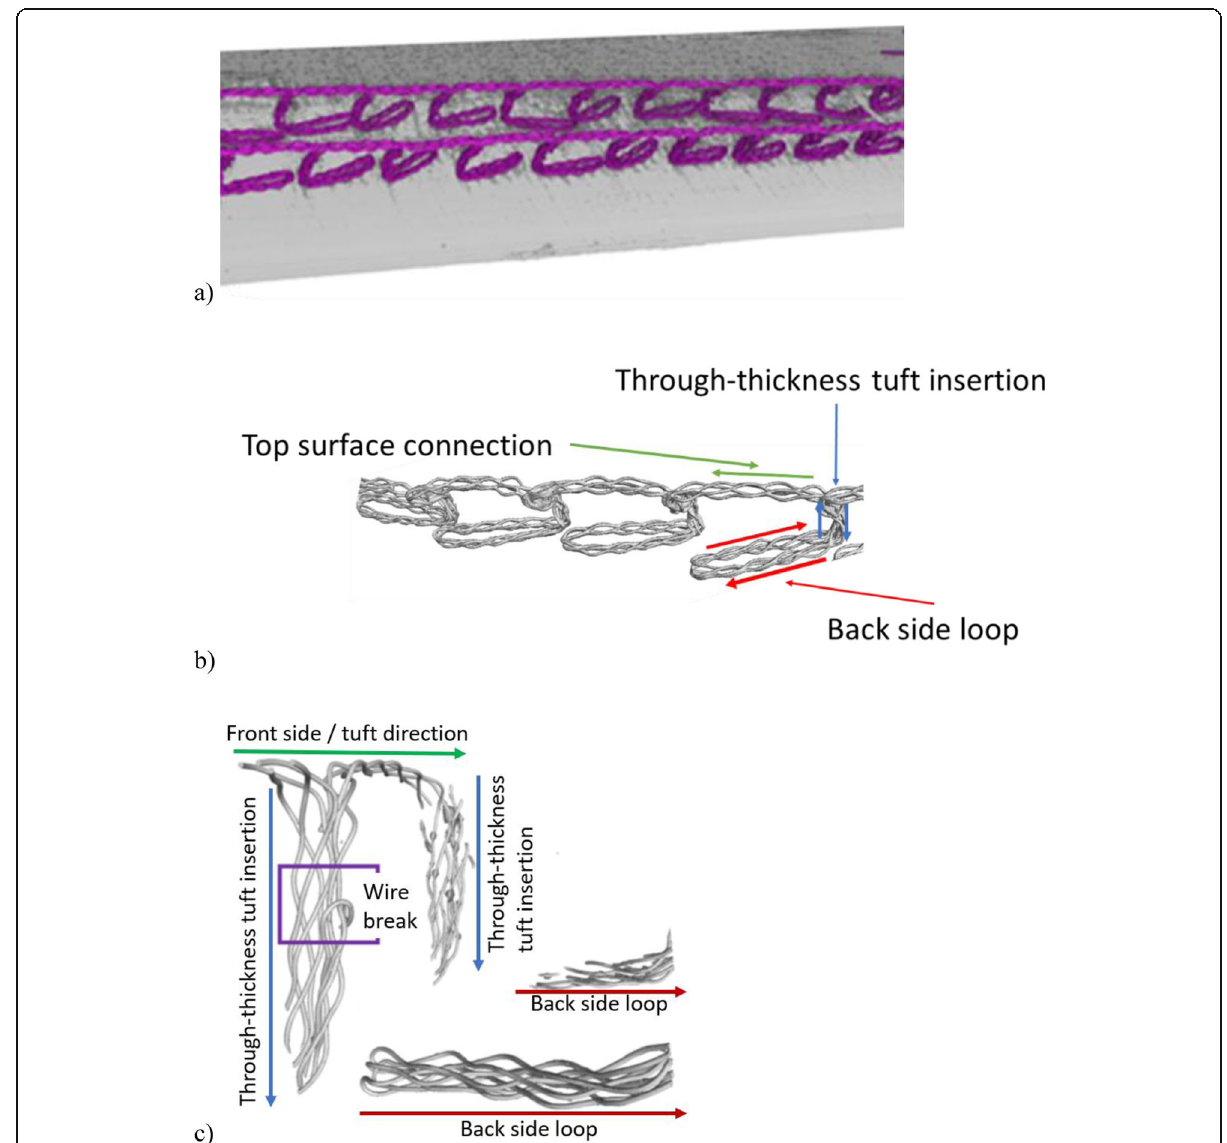
Fig. 5 CT scan highlighting path of metal wire in tufted composite. a two rows of tufts (metal is highlighted in pink colour), b closer look at neighbouring insertion of a tuft, c higher resolution of a single tuft